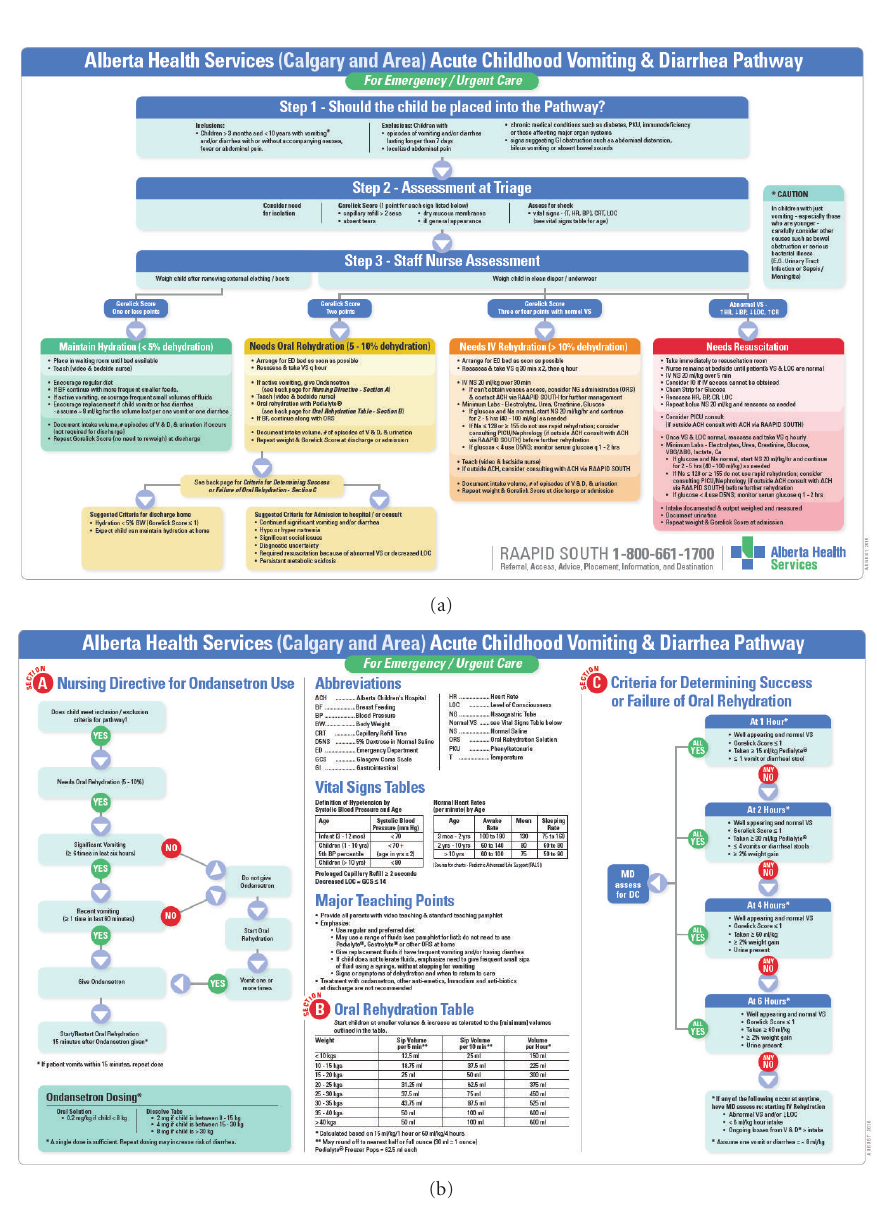
Figure 7: The Alberta Children’s Hospital Acute Vomiting and Diarhhea Pathway. Note the use of the Gorelick score in guiding fluid hydration and medication